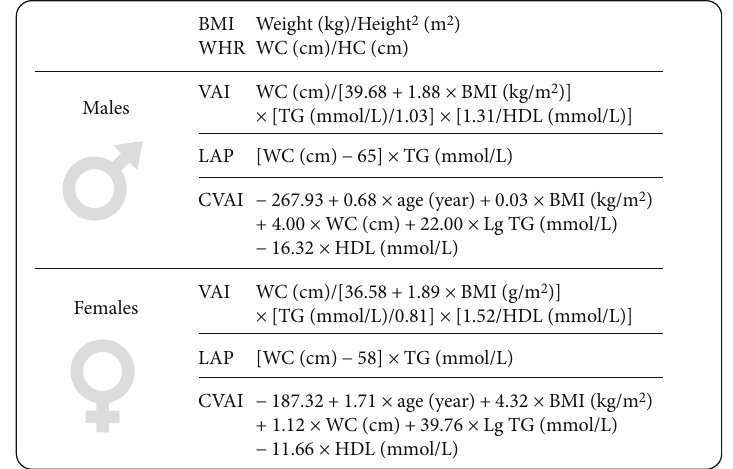
Figure 3: Calculation formulas of the abdominal obesity index for males and